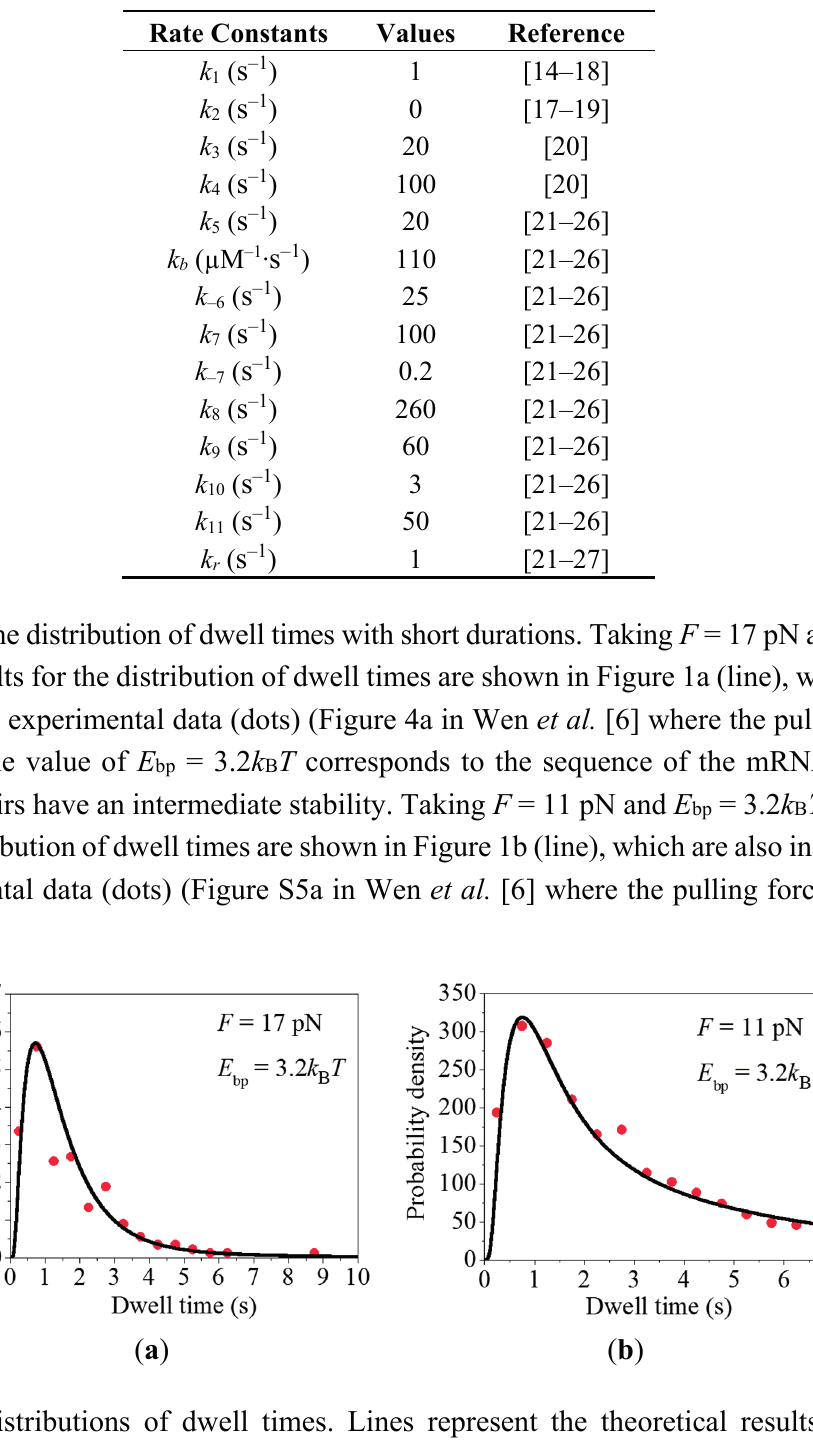
Figure 1. Distributions of dwell times. Lines represent the theoretical results and dots represent the experimental data taken from Wen et al. [6]. In order to make a direct comparison with the experimental data, we multiply the calculated distribution of dwell times, h ( t ), by a constant C . ( a ) The theoretical results are calculated with F = 17 pN and E bp = 3.2 k B T . The experimental data are taken from Figure 4a in Wen et al. [6] (reproduced with permission from Nature); ( b ) The theoretical results are calculated with F = 11 pN and E bp = 3.2 k B T . The experimental data are taken from Figure S5a in Wen et al. [6] (reproduced with permission from